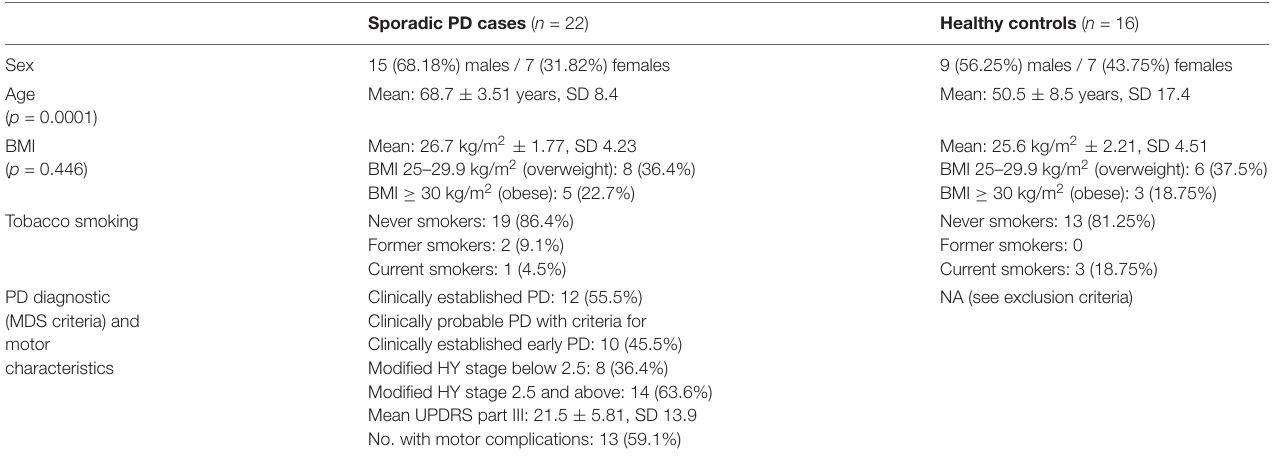
TABLE 1 | Demographic and clinical characteristics of the study